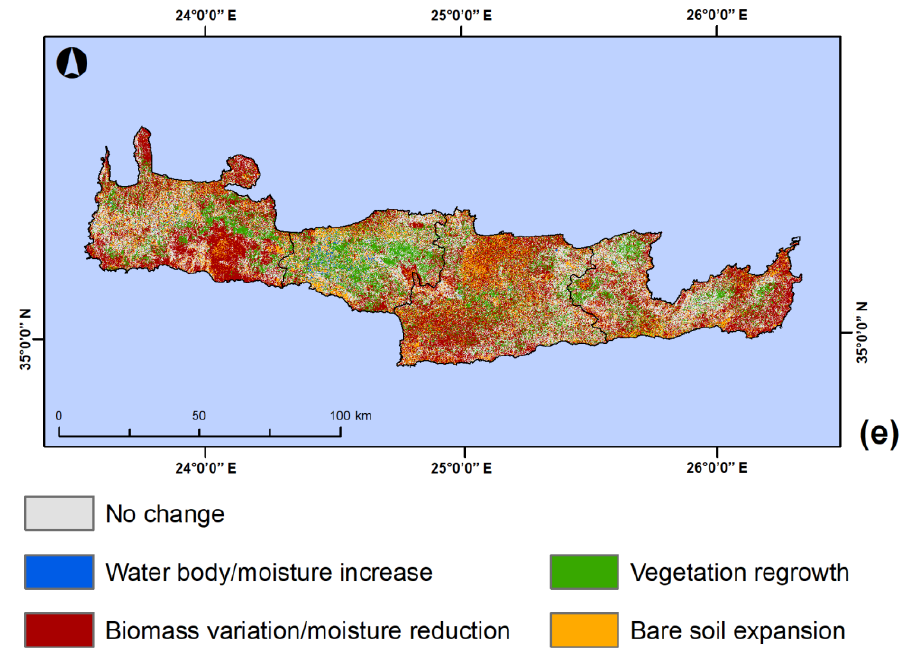
Figure 5. Change direction maps for the period of 1999–2009 from di ff erent index combinations: ( a ) NDVI–albedo; ( b ) NDVI–BSI; ( c ) SAVI–albedo; ( d ) SAVI–BSI; ( e ) TCG–TCB.